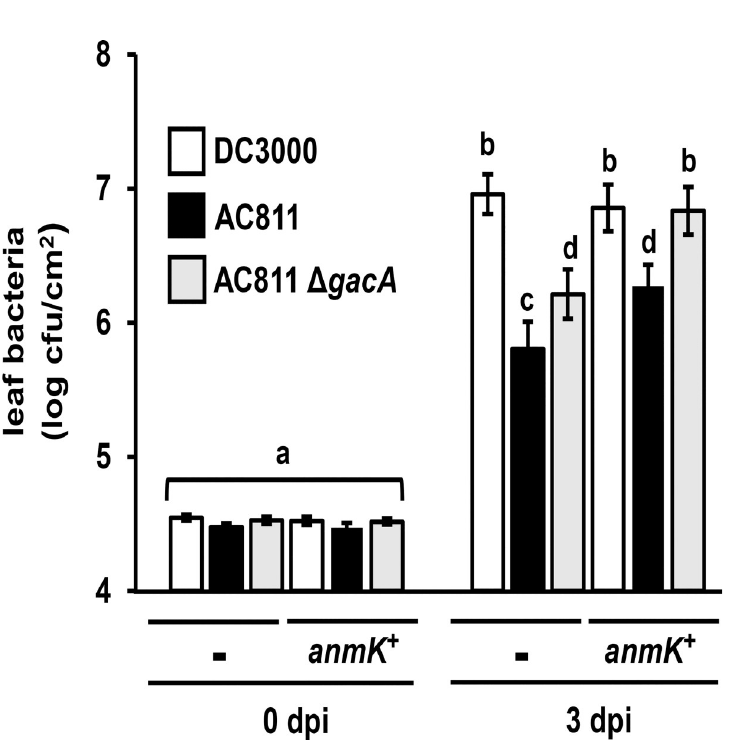
Fig 4. Growth of AC811 in arabidopsis is fully restored by eliminating Tn 5 effects on uvrC and by expression of a wild-type anmK allele. Arabidopsis leaves were syringe-infiltrated with DC3000, AC811 or AC811 Δ gacA carrying either pME6010 empty vector or pME6010:: anmK . Graphed are means ± SE of leaf bacteria enumerated by serial dilution plating; n = 3. Abbreviation dpi is days post-infection. Data are pooled from four independent experiments; n = 12. Statistical groups were determined by ANOVA with multiple pairwise t -test comparisons and Tukey’s post-hoc HSD analysis, p < 0.05.